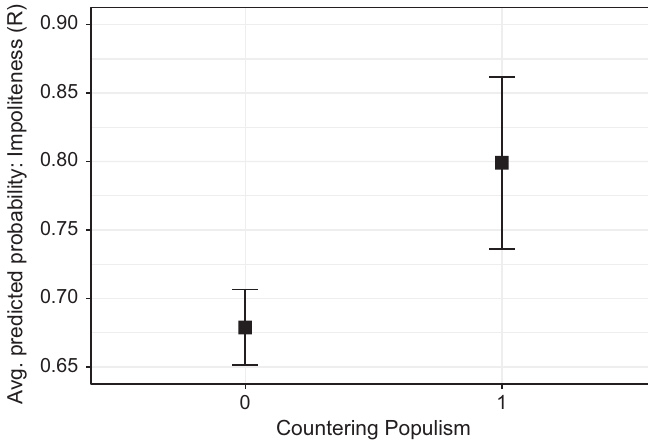
Figure 3. Average predicted probabilities of impoliteness in replies. Note: 95% confidence